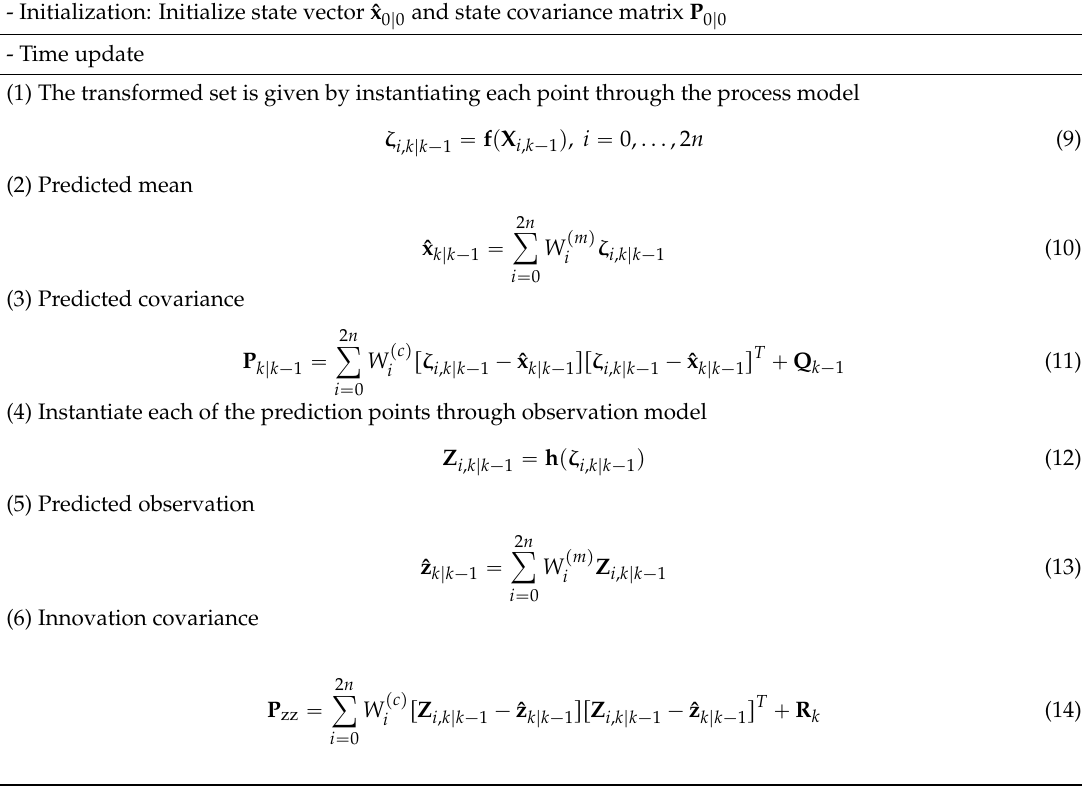
Table 1. Implementation algorithm for the unscented Kalman